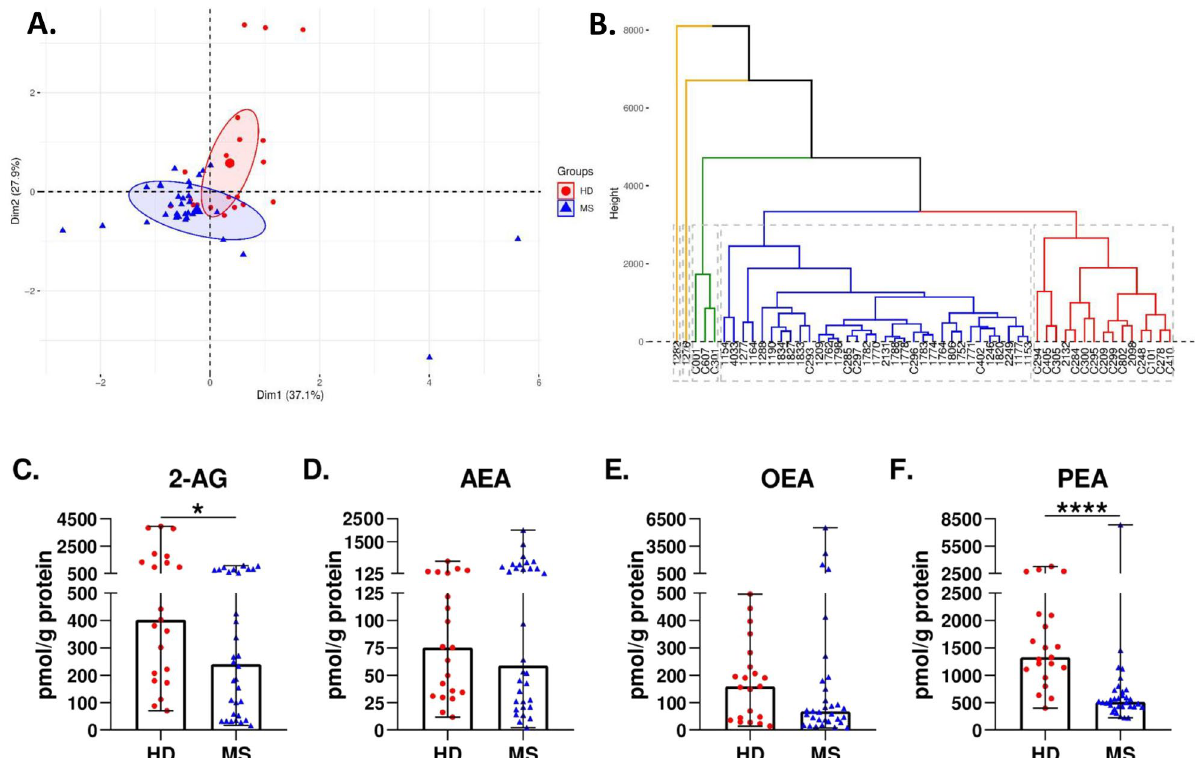
Figure 1. Endocannabinoid levels are dysregulated in MS patients compared to HD. ( A ) Principal component analysis of the endocannabinoid profile in HD and MS patients at baseline. HD (red) locate in a differentiated region of space compared to MS patients at baseline (blue) ( B ) Hierarchical clustering of HD and MS patients at baseline imputed from the four endocannabinoids (2-AG, AEA, OEA and PEA). HD are indicated with a C and their corresponding sample number . ( C – F ) Individual levels (in pmol/g of protein) of each endocannabinoid in HD and MS patients at baseline. MS patients presented lower levels of 2-AG and PEA. The Mann–Whitney test was used to compare differences between groups. Data are expressed as median with range. *p < 0.05; ****p < 0.0001; ns, not